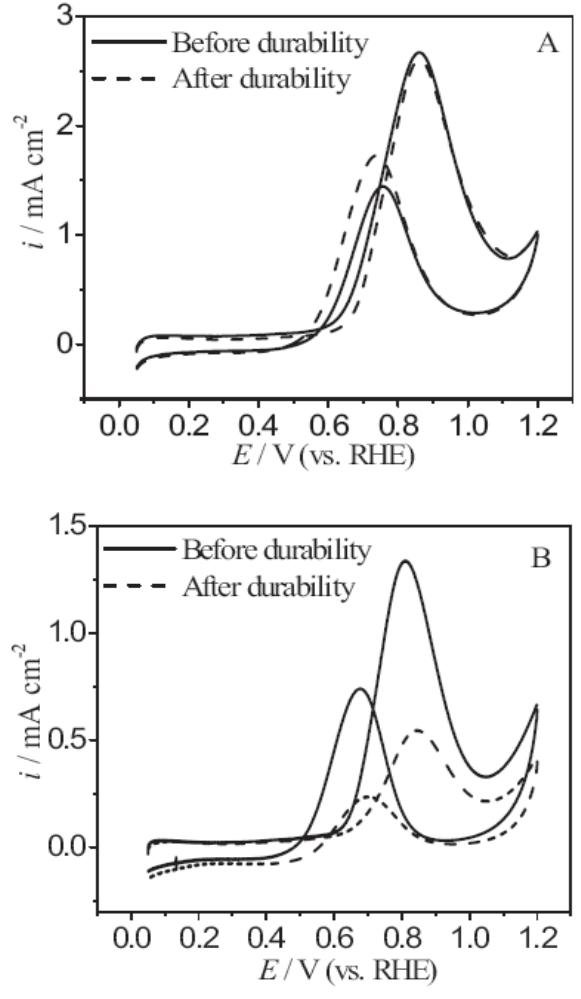
Figure 9. CV traces of methanol electro-oxidation on (A) PtNiPb/WC and (B) PtNiPb/C catalysts in a solution of 0.5 M CH durability test (Reprinted from Reference 91 with